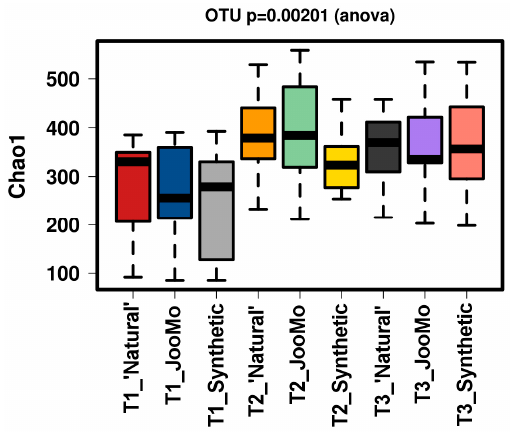
Figure 1. Chao1 of the different time points per group. There is a significant increase in diversity in all groups over time. The samples were normalised to a read depth of 534 sequences.